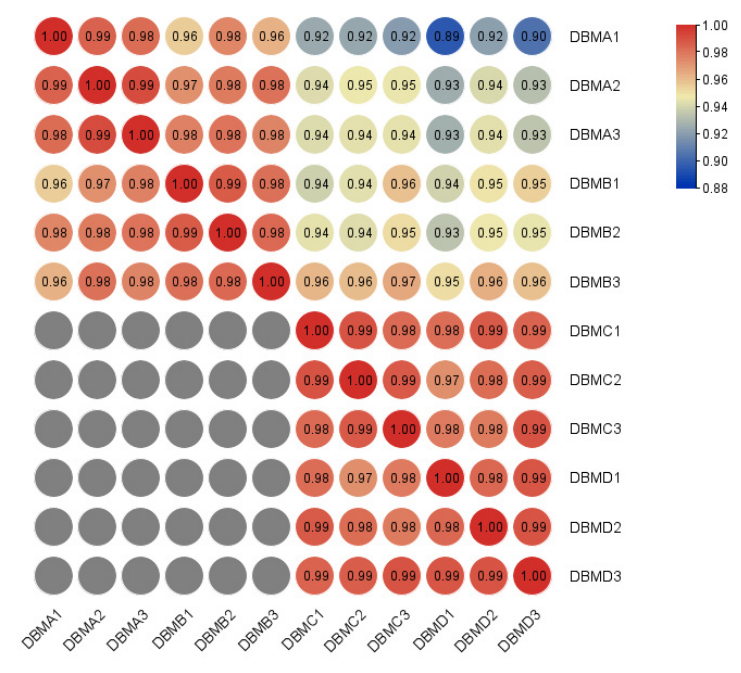
Figure 4. The number of differentially expressed genes with different values of log 2 fold-change between susceptible (G88, DBMA) and resistant (Cry1S1000, DBMC) strains.